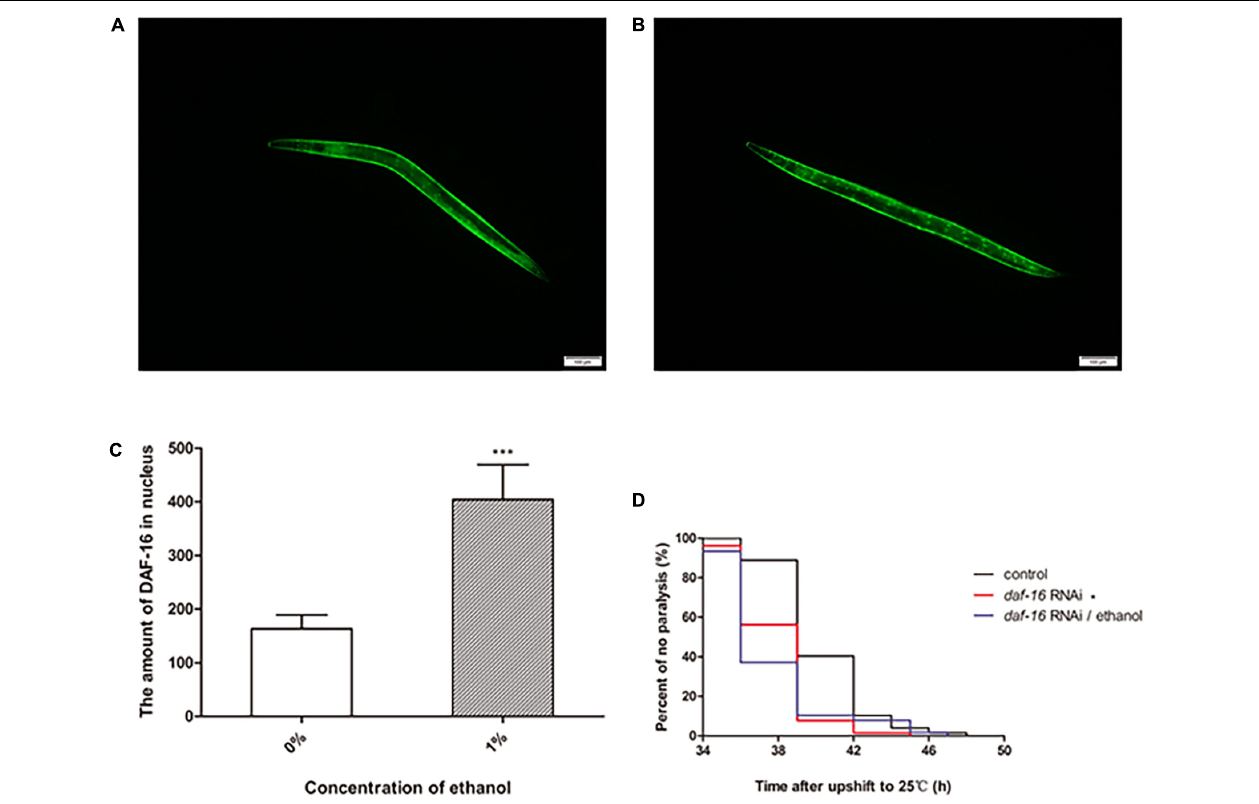
FIGURE 5 | The effect of DAF-16 on ethanol-regulated amyloid-beta toxicity of C. elegans . Fluorescent microscopy was used to measure DAF-16 localization in TJ356 transgenic worms treated without ethanol (A) and with ethanol, n = 15 (B) . The photo was taken using a 10 × objective with a fluorescent microscope. (C) The amount of nuclear DAF-16::GFP was evaluated by Image J between ethanol-treated group and the control. The graph represents the mean ± SD. (D) Worms were fed with daf-16 RNAi bacteria or daf-16 RNAi bacteria and ethanol or empty vector bacteria as control, n > 100. Data represents the paralysis analysis of C. elegans at each condition. * p < 0.05 and *** p < 0.001.